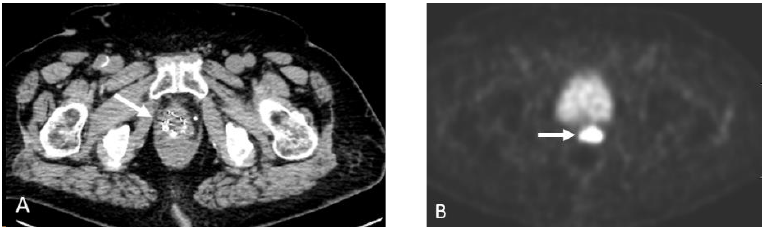
Figure 17. Ninety-two-year-old male with stage IV prostate cancer, status post-brachytherapy, now with biochemical recurrence. NECT image ( A ) shows brachytherapy seeds in the prostate base (arrow) without a discernable abnormality. Corresponding 18F DCFPyL PET image ( B ) shows intense radiotracer uptake in the left prostate base and extending across midline.